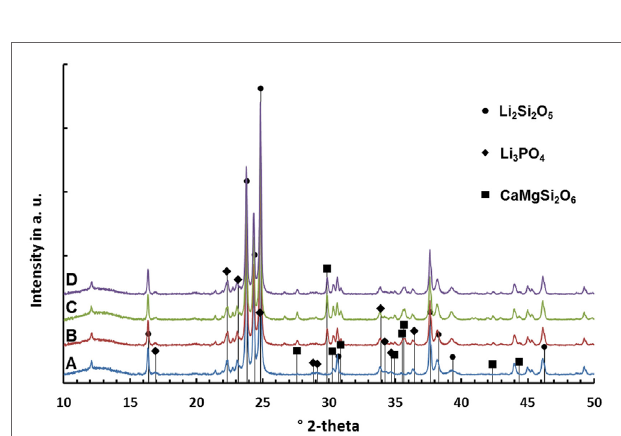
FigUre 5 | Diffractograms of glass-ceramics after sintering at 860°c for 5 min .